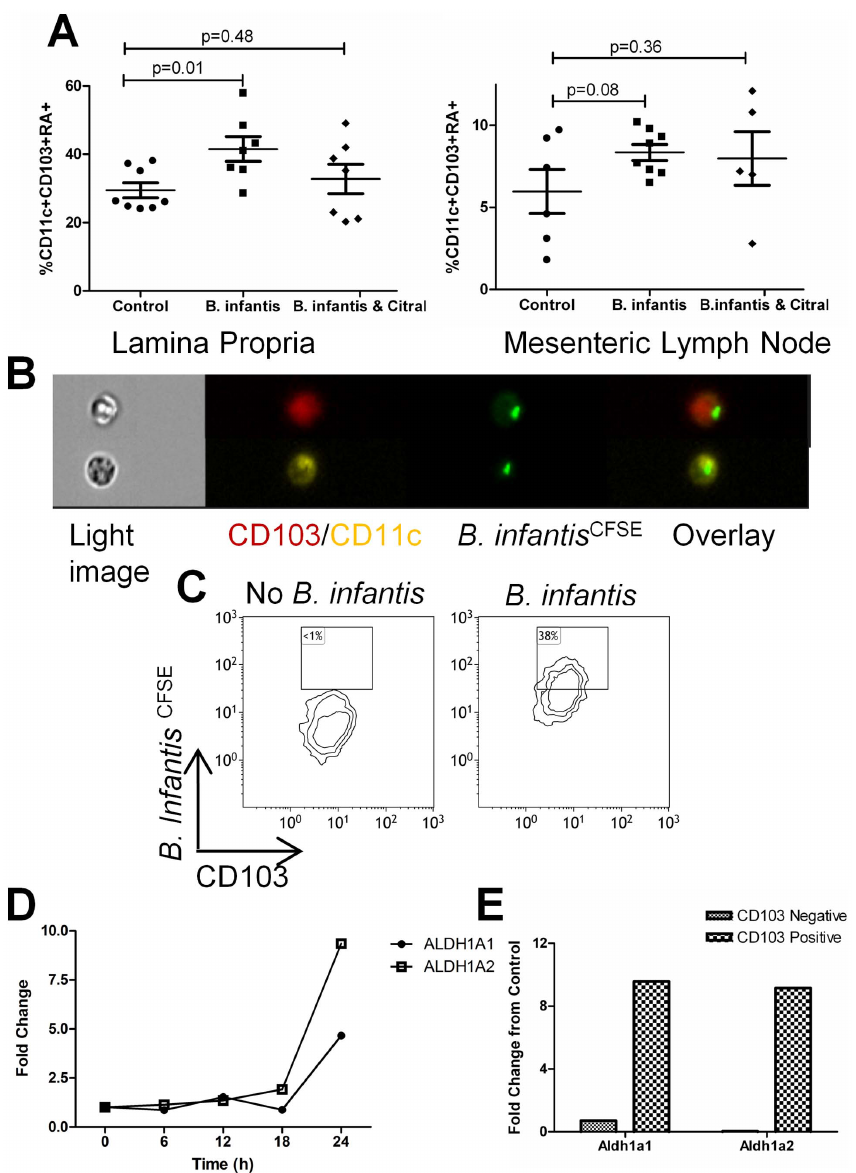
Figure 2. CD103 + RALDH + dendritic cells are elevated in the LP following B.infantis feeding. Flow cytometric assessment of LP and MLN revealed that B. infantis feeding is associated with increased CD103 + RALDH + dendritic cells within the LP (n=7), compared to the control group (n=8), analysed using unpaired student t-tests ( a ). Citral blocked the increase in LP CD103 + RALDH + dendritic cells (n=7). ( b ) Multispectral flow cytometry imaging identified CD103 + dendritic cells that efficiently bind CFSE-labelled B. infantis . ( c ) Flow cytometric analysis of CD11c + MHCII + CD103 + dendritic cells from the mucosa demonstrated that approximately 38% of CD103 + dendritic cells bound B. infantis . Isolated mucosal CD11c + dendritic cells upregulate mRNA for RALDH enzymes following in vitro incubation with B. infantis ( d ), while the increase in gene expression is specific to CD103 + dendritic cells ( e ). doi:10.1371/journal.pone.0062617.g002 within the LP and B. infantis feeding partially reversed the drop in Foxp3 + lymphocytes within the LP ( Figure 6b ). As described of DSS-induced colitis (Figure 5a) or LP T H 1 and T H 17 subsets (Figure 6a). However, B. infantis significantly reduced the numbers above, B. infantis feeding to healthy animals significantly reduced a 4 b 7 + and CCR9 + lymphocytes within the LP, however B. infantis of IL-17 + and IFN-gamma + lymphocytes within the LP of colitic animals, which was blocked by citral treatment ( Figure 6a ). The feeding to animals with DSS-induced colitis did not alter a 4 b 7 + or CCR9 + lymphocyte numbers ( Figure 6c ). Colitis was associated proportion of Foxp3 + lymphocytes within the MLN increased significantly due to the induction of colitis and B. infantis feeding with significantly increased numbers of CD103 + dendritic cells had no effect on the increase in Foxp3 + lymphocytes within the within the LP ( Figure 7a ). However, the percentage of CD103 + MLN ( Figure 6b ). In contrast, DSS-induced colitis was associated dendritic cells that were RALDH + were significantly reduced in with a significantly reduced percentage of Foxp3 + lymphocytes the control DSS group, while B. infantis feeding reversed the